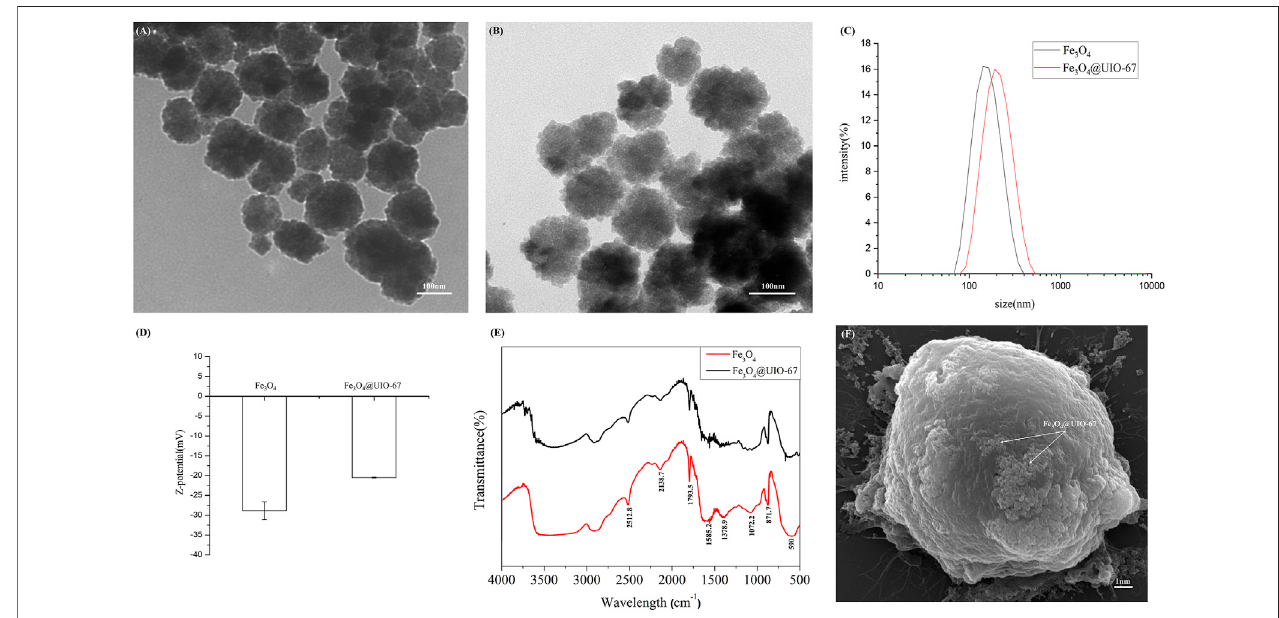
FIGURE 2 | (A) Images of TEM for pure Fe 3 O 4 . (B) Images of TEM for Fe 3 O 4 @UIO-67. (C) Hydrodynamic diameter values for Fe 3 O 4 and Fe 3 O 4 @UIO-67 preparations measured via DLS. (D) Zeta potential values for Fe 3 O 4 and Fe 3 O 4 @UIO-67 preparations. (E) Fe 3 O 4 and Fe 3 O 4 @UIO-67 FTIR spectra. (F) Representative